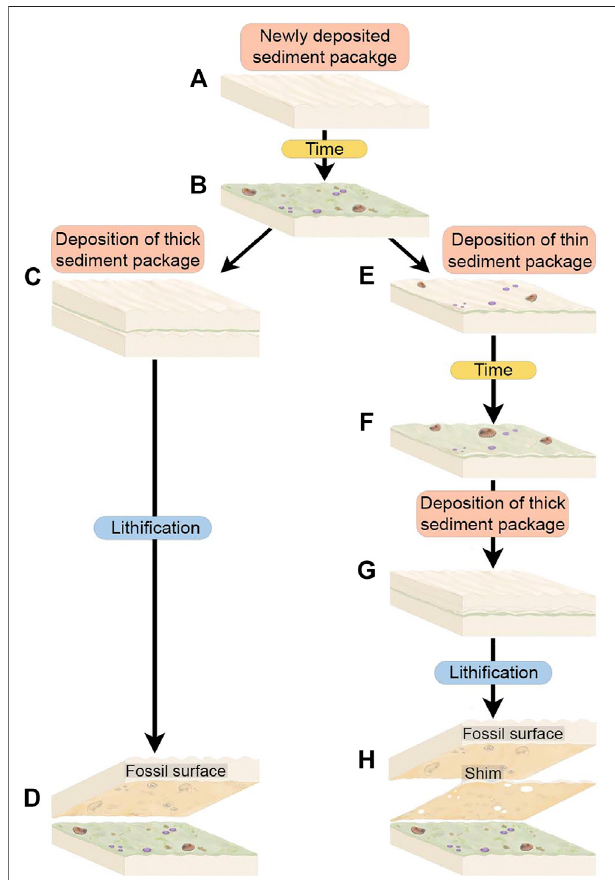
FIGURE 5 | Schematic of depositional scenarios with thick sediment packages and with thin sediment packages or “ shims ” . (A) Immediately after deposition, the uppermost sediments are rippled and have not yet developed TOS. (B) Over an ecologically signi fi cant period time, TOS develops on the sediment package and Ediacara macrobiota begin to colonize the substrate. (C) A thick sediment package is deposited on top of the TOS and macrobiota community, representing fi nal burial of this surface. (D) The resulting fossil surface is preserved on the base of the thick depositional event and preservesTOSassociatedwithEdiacara macrofossilsononesurface. (E) An alternate scenario wherein the TOS macrobiota community is overlain by a thin “ shim ” of sediment that does not completely bury sessile organisms such as Tribrachidium and allowsmobileorganisms suchas Dickinsonia toescape. (F) Over an ecologically signi fi cant period of time this shim develops TOS and partially buried sessile organisms and unburied mobile organisms continue to live. (G) A thick sediment package is deposited on top of the shim so that the underlying community is completely buried. (H) The resulting fossil surface preservesboth theshimand theoverlyingthicksedimentpackageasdiscrete surfaces. The shim preserves the TOS from the original community and holes